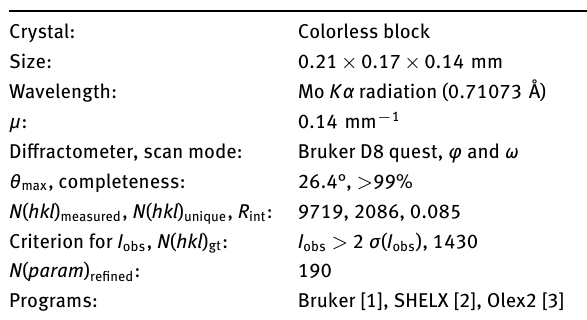
Table 1: Data collection and handling.